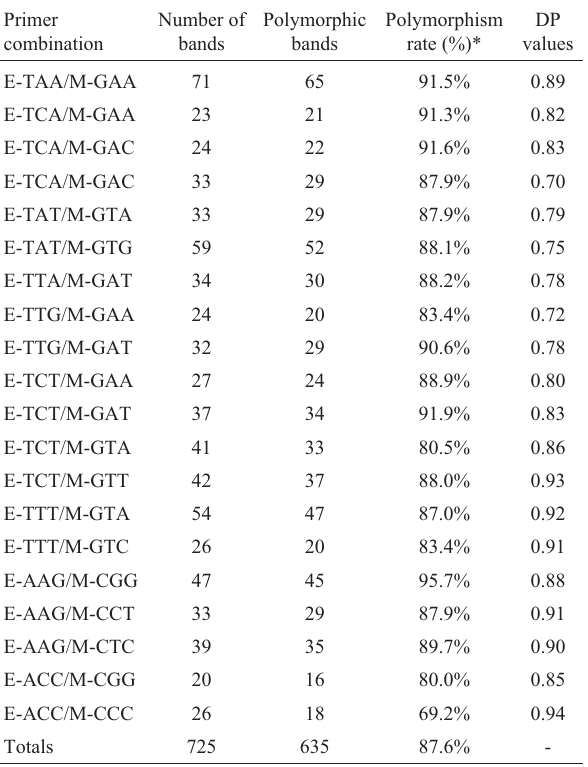
Table 3 - AFLP primer combinations and their characteristics. Primer